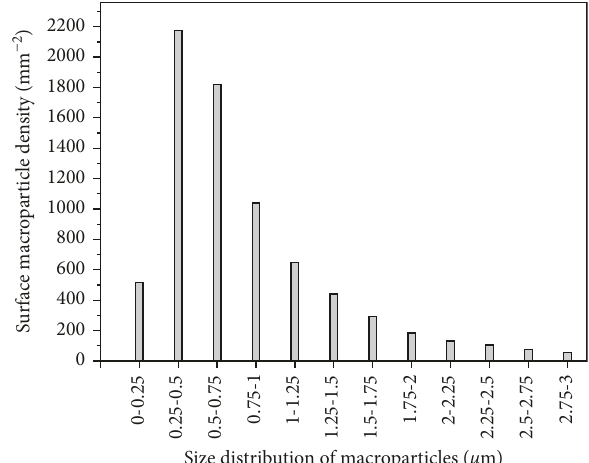
Figure 10: Size distribution and macroparticle density of the CrN coating on 42CrMo4 steel